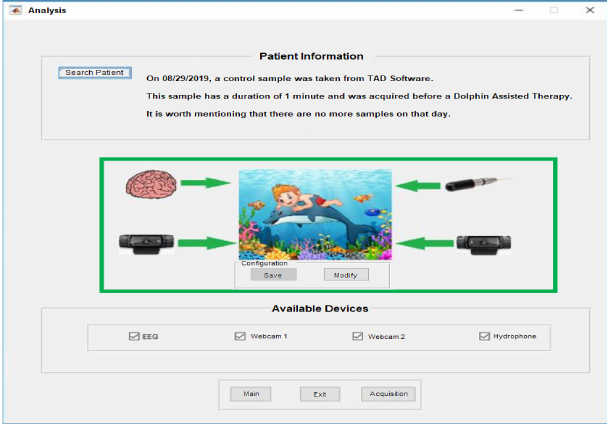
Figure 12. Basic patient information and the devices configuration.